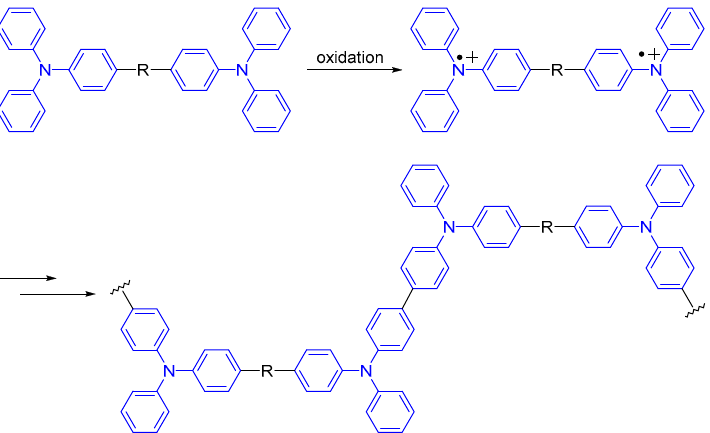
Figure 1. Schematic representation of the electropolymerization of triphenylamine monomers. R stands for any building block between two triphenylamine units.